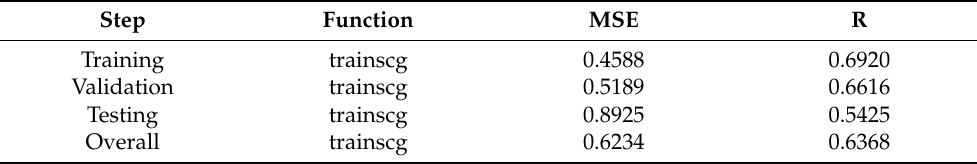
Table 6. Summary of different model evaluation parameters of SCGB